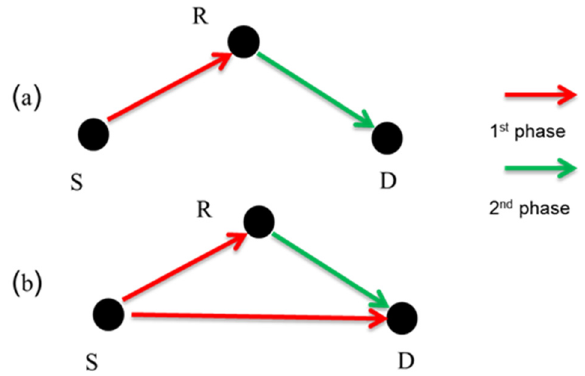
Figure 1. The system model without SWIPT. ( a ) the signal from a source to a destination through the relay; ( b ) the signal from a source to a destination through the relay with direct path.